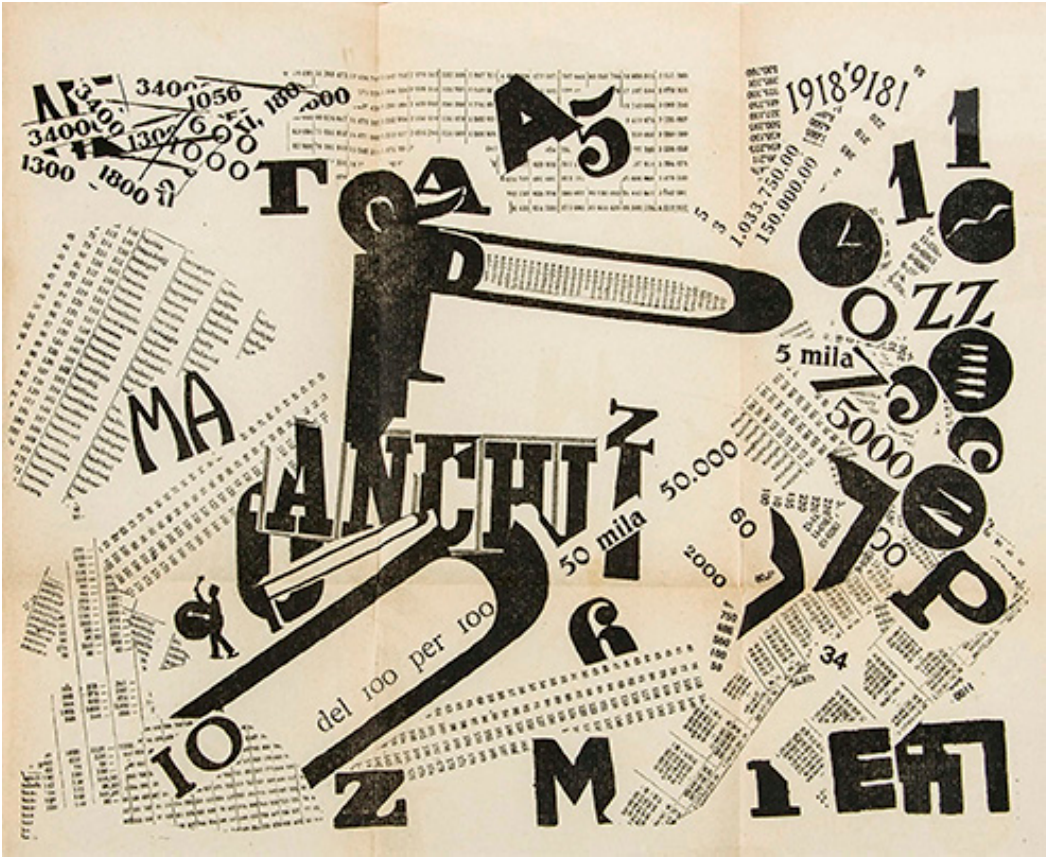
Figure 1. Detail of a spread. Filippo Tommaso Marinetti, Les Mots en Liberté Futuristes ,